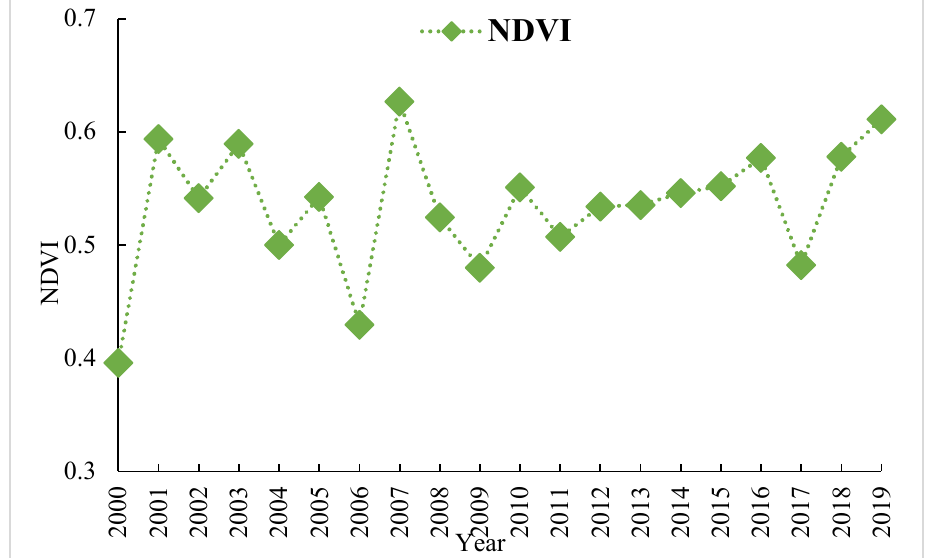
Figure 4. Temporal trend of VG in dry seasons of Mara River Basin.